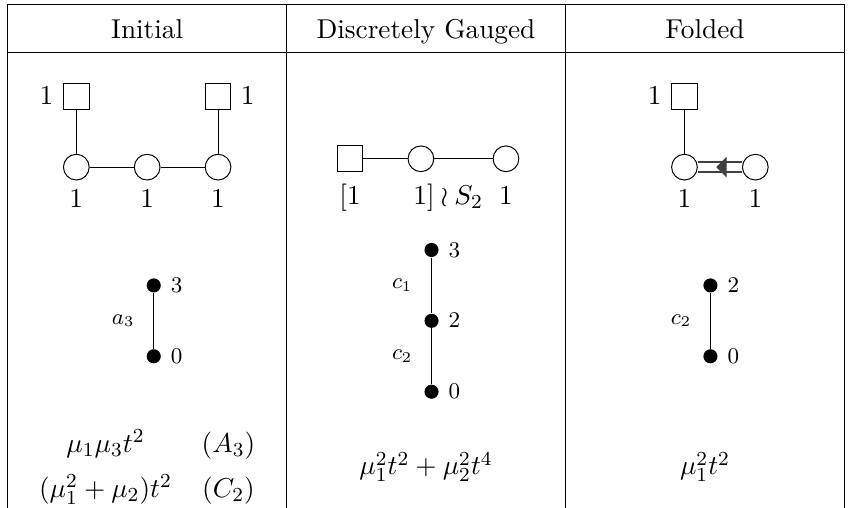
Table 9 . A 3 minimal nilpotent orbit and its discrete